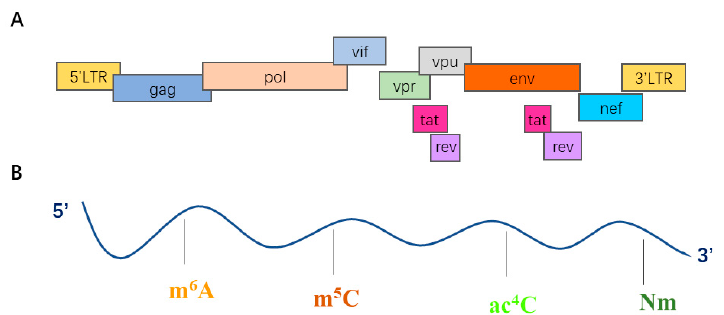
Figure 2. ( A ) Structure and organization of the HIV-1 genome. There are the reading frames of the genes coding for structural and regulatory proteins. ( B ) Epitranscriptomic modifications of HIV-1 RNA. The indicated epitranscriptomic marks are m 6 A, m 5 C, ac 4 C and Nm. Replication and infection of HIV-1 virus are also regulated by RNA